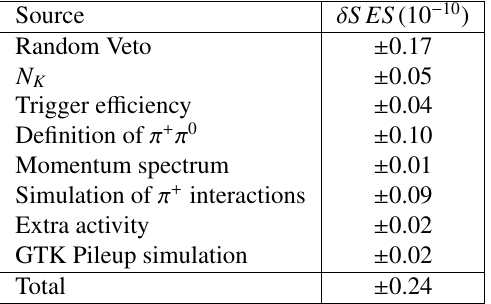
Table 1. Summary of the systematic uncertainties for the S ES computation.